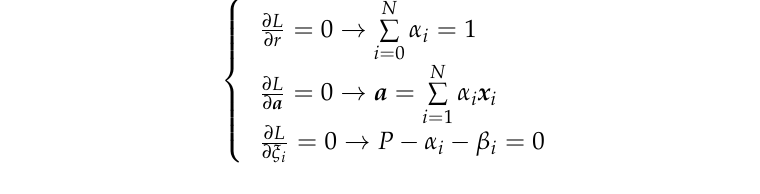
Figure 4. Schematic of SVDD in two–dimensional space.